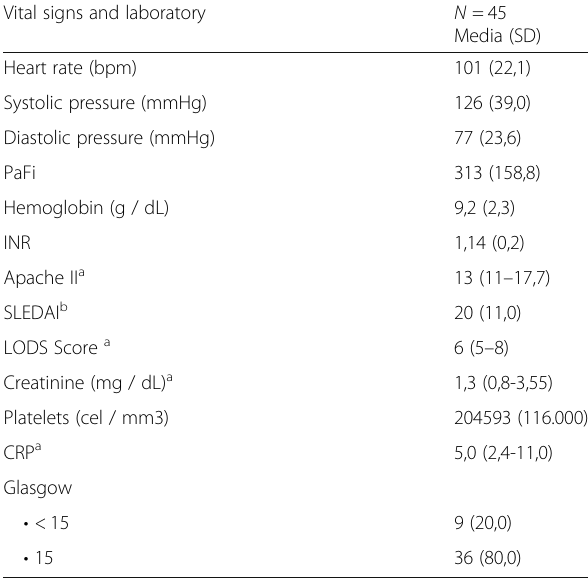
Table 4 Vital signs and laboratory upon admission to the ICU Vital signs and laboratory N = 45